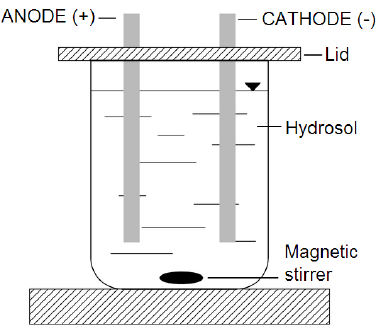
Figure 1. Schematic of the experimental set-up.